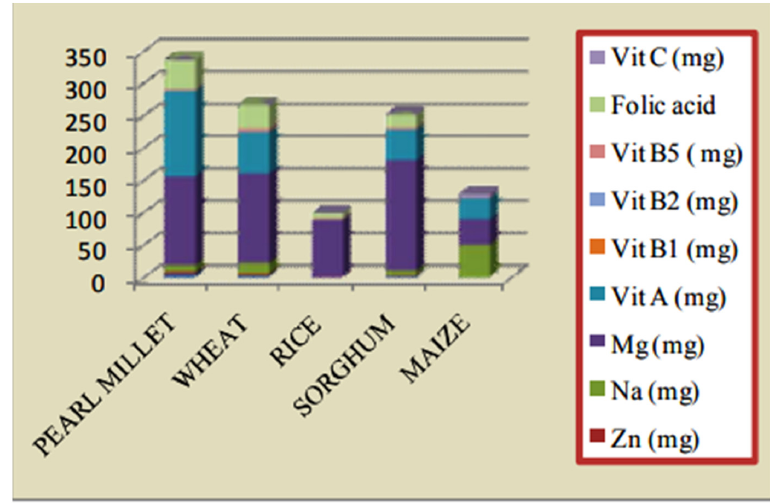
Figure 2. Comparison of nutritional values of pearl millet with other millets. Table 1. Nutritional value of Pearl Millet.